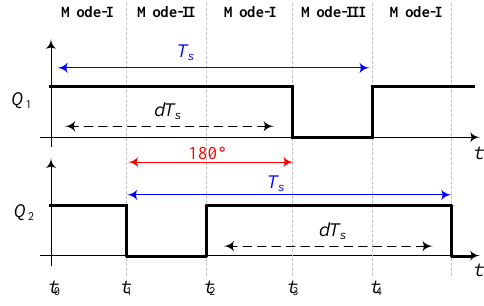
Figure 5. The controlling signal of the MOSFETs. Both duty cycles are assumed to be the same, and they are phase